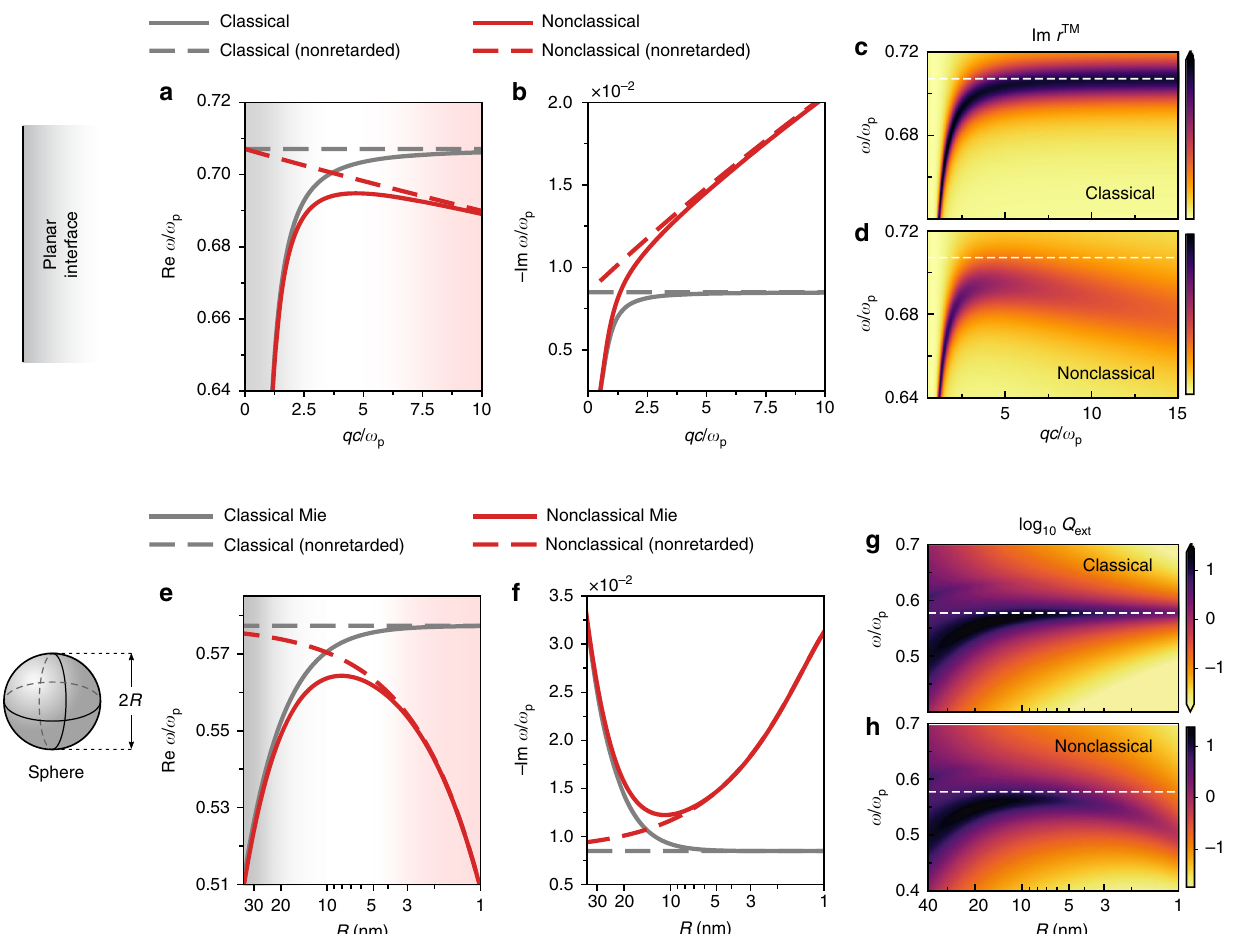
Fig. 2 Nonclassical corrections to plasmonic spectral properties. a Dispersion relation of the surface plasmon frequency and b resonance width at a planar semi-in fi nite air – metal interface. c – d Im r TM in the classical and nonclassical treatments. Horizontal white dashed lines mark the nonretarded ffiffiffi p = classical surface plasmon at ω 2 . e Radius-dependent dispersion of the dipole LSP frequency and f resonance width in metal spheres. g Classical and p h nonclassical normalized extinction cross-sections [ Q ext (cid:5) σ ext = π R 2 ] for plasmonic spheres. White dashed lines mark the nonretarded classical